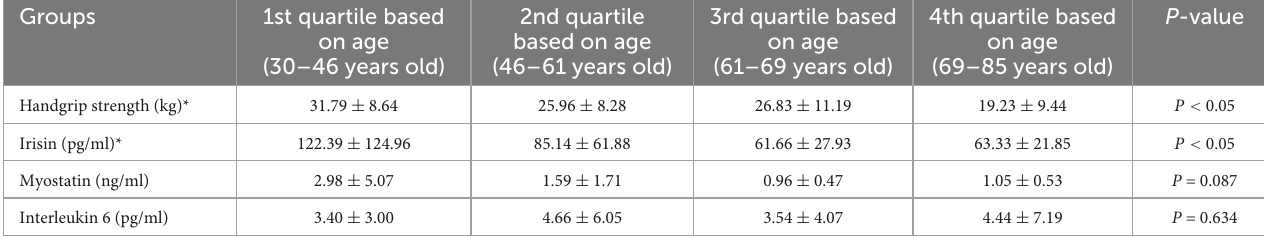
TABLE 6 The concentration of myokine and handgrip strength between the participants based on the quartile divided by age. Groups